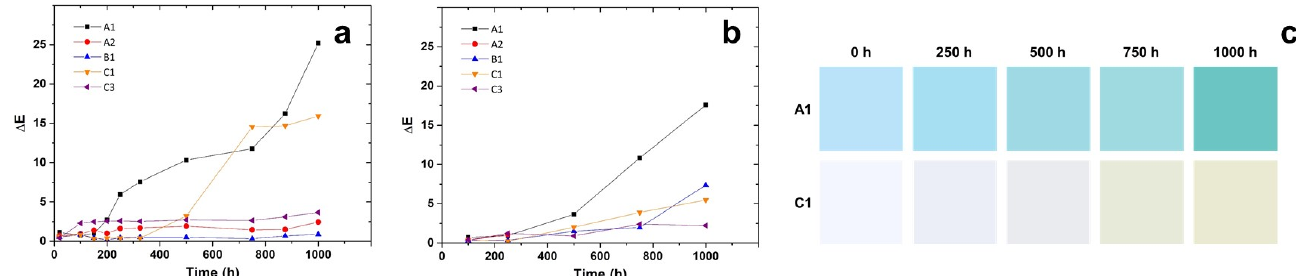
Figure 5. Color changes of PP layers exposed to isothermal aging at 110 °C ( a ) and accelerated photoaging at 24 °C ( b ) as a function of treatment time, and an example of the chromatic evolution of layers A1 and C1 exposed to isothermal aging at 110 °C ( c ).